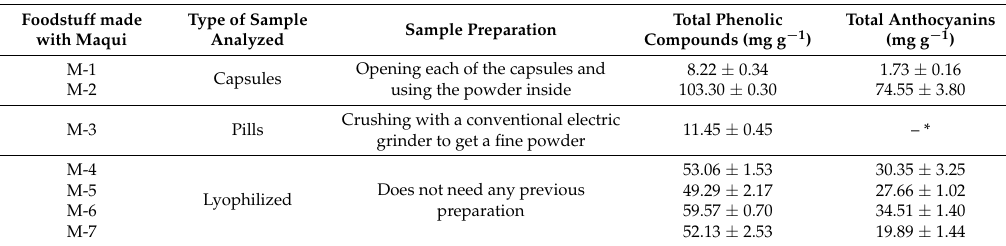
Table 3. Concentrations of total phenolic compounds (mg g − 1 ) and total anthocyanins (mg g − 1 ) in different real samples made with maqui ( n =